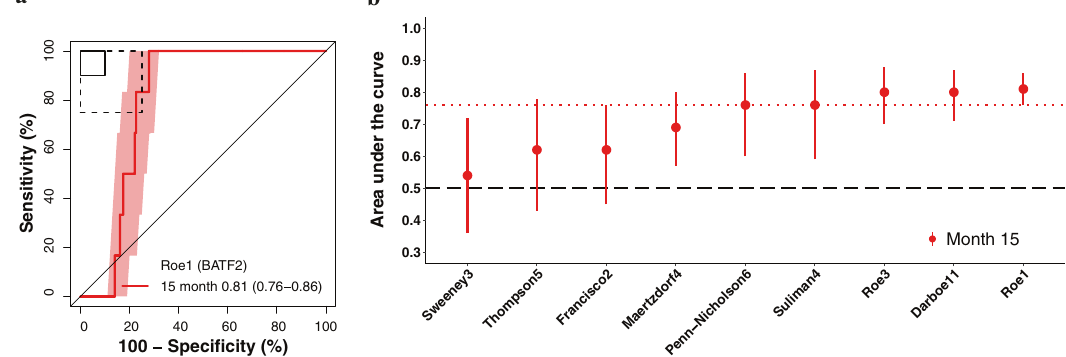
Fig. 5 Parsimonious signature prognostic performance for incident TB in people living with HIV. a Representative receiver operating characteristic (ROC) curve depicting prognostic performance (area under the curve, AUC, with 95% CI) of the parsimonious signature with the best prognostic performance (Roe1/BATF2 signature) for incident TB diagnosed on two or more liquid culture-positive or Xpert MTB/RIF-positive sputum samples (primary endpoint) through 15 months follow-up in the CORTIS-HR study of people living with HIV. ROC curves for the other signatures are in the Supplementary Information (Fig. S8). The shaded areas represent 95% CIs. The solid box depicts the optimal criteria (90% sensitivity and 90% speci fi city) and the dashed box depicts the minimal criteria (75% sensitivity and 75% speci fi city) set out in the WHO Target Product Pro fi le for an incipient TB test 21 . b Summary of signature prognostic performance in the order of primary endpoint AUC estimates through 15 months follow-up. The midline indicates the AUC estimate, the error bars indicate the 95% CIs, the red dotted line indicates the lower bound of the 95% CI for the best performing signature for the primary endpoint, and the black dashed line indicates an AUC cut-off of For primary endpoint incident TB, none of the signatures met the minimal WHO TPP benchmark for a prognostic test (sensitivity 75% and speci fi city 75%) in the HIV-uninfected cohort through 15 months follow-up (Table S12 in Supplementary Data 1); the Roe3 signature came closest at its optimal cut-point (sensitivity 70.0%, 95% CI 46.0 – 92.9; speci fi city 72.9%, 95% CI 71.1 – 74.7). However, through 6 months follow-up, six of eight parsimonious signatures met the minimal benchmark. The remaining two signatures, Suliman4 and signatures (except Maertzdorf4 and Sweeney3) also met or Sweeney3, approached it with upper limits of the 95% con fi dence approximated this benchmark. intervals for prognostic estimates exceeding the benchmark bounds (Table S12 in Supplementary Data 1). Only RISK11 met the optimal WHO TPP benchmark for a prognostic test (sensitivity 90% and Most TB signatures failed to differentiate participants with speci fi city 90%) through 6 months. Through 12 months follow-up, upper respiratory viral pathobionts from those with TB dis- the upper limits of the 95% con fi dence intervals for all signatures ease . Amongst participants with HIV we found that those without exceeded the minimal WHO TPP benchmark, but only the TB who had a detectable HIV plasma viral load ( ≥ 100 copies/mL)